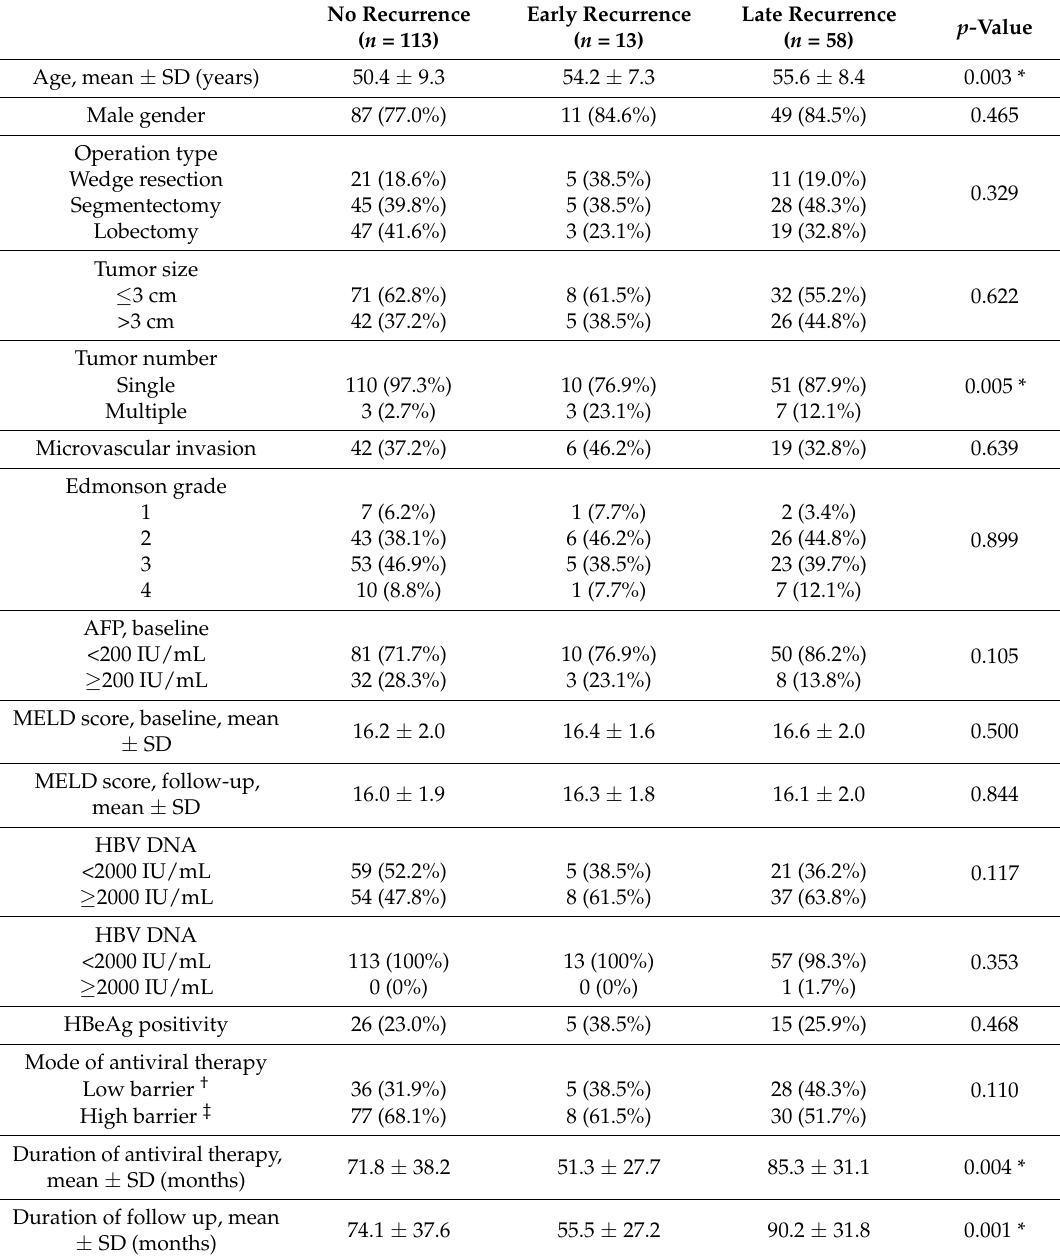
Table 1. Demographic findings of HBV-related HCC patients with cirrhosis treated with liver resection and put under antiviral